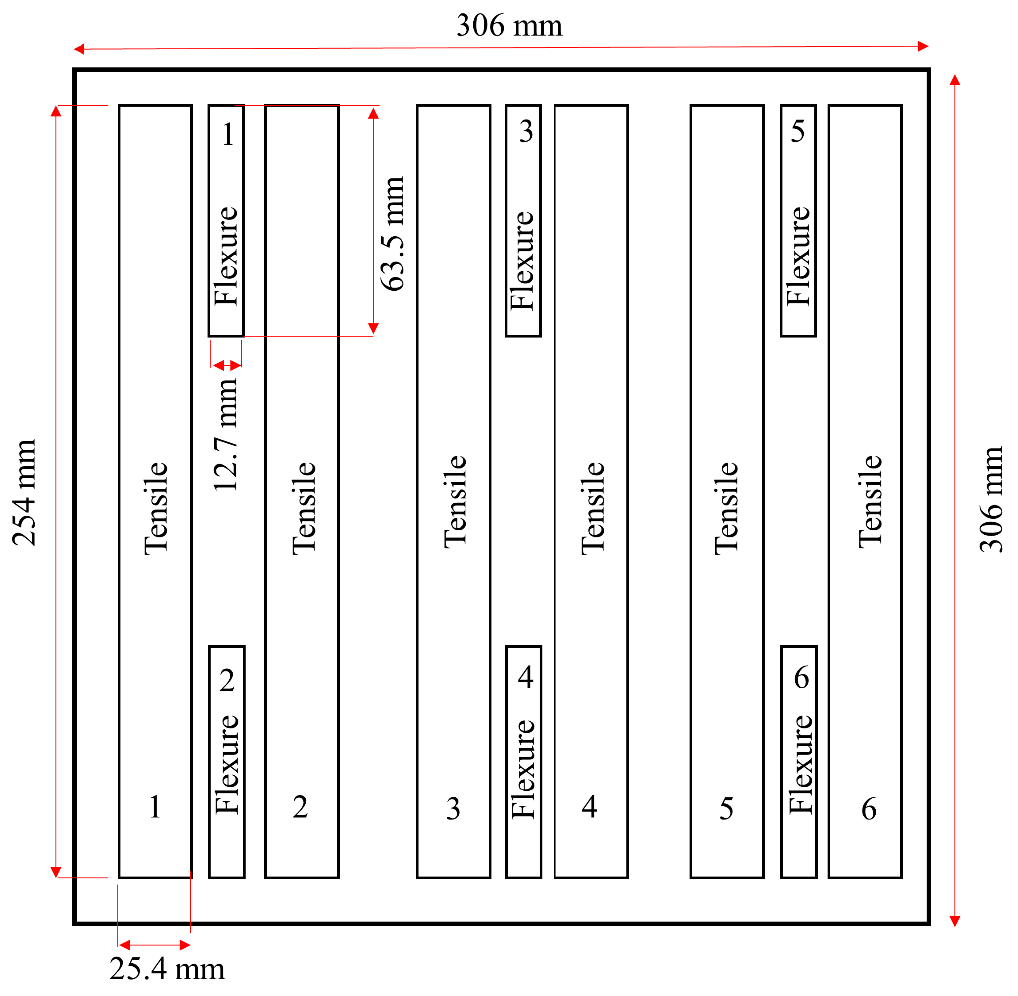
Figure 2. Location of tensile and flex samples machined from the WL nonwoven carbon fiber composite plates .